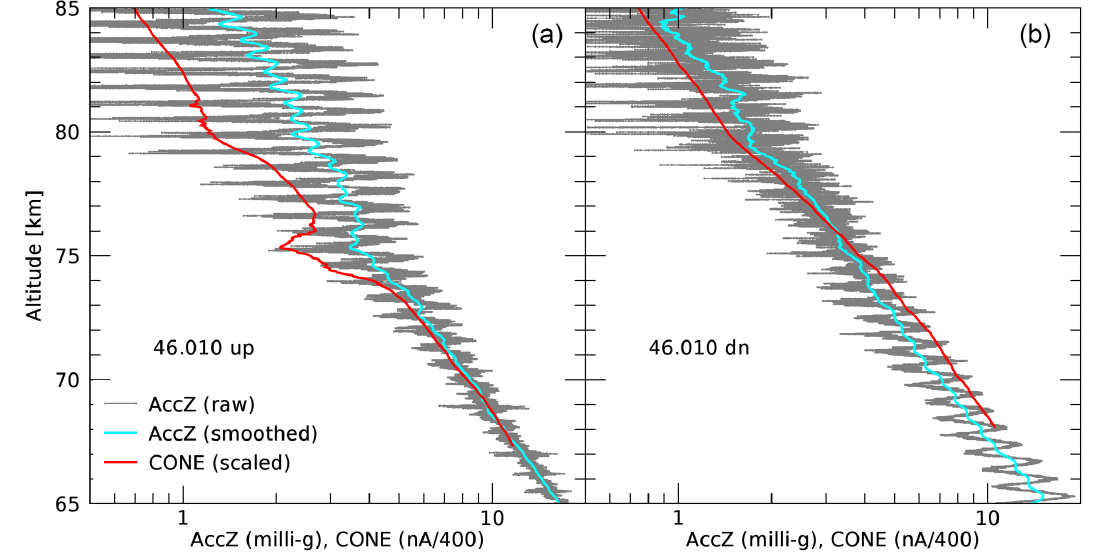
Figure A1. Accelerometer drag residual for flight 46.010 upleg (a) and downleg (b)